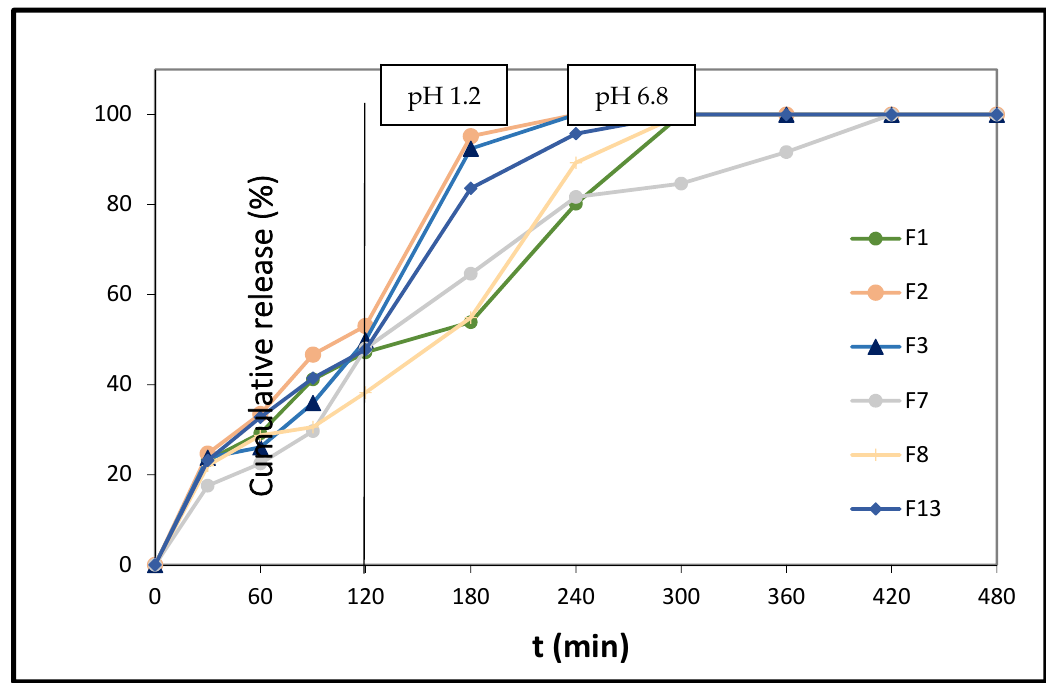
Figure 5. In vitro % release of melatonin from formulations F1, F2, F3, F7, F8, and F13 vs. time. The results represent the mean value (n = 3, SD < 2).